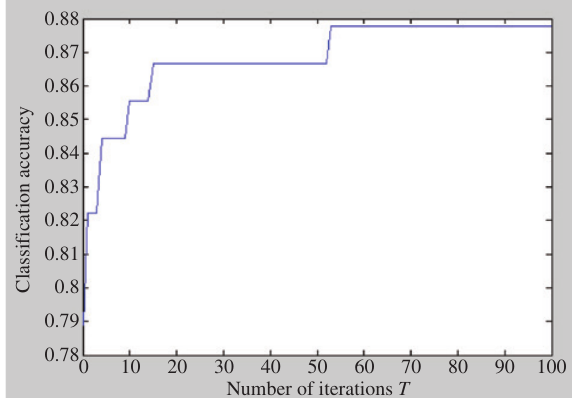
Figure 6: Result of the Process of